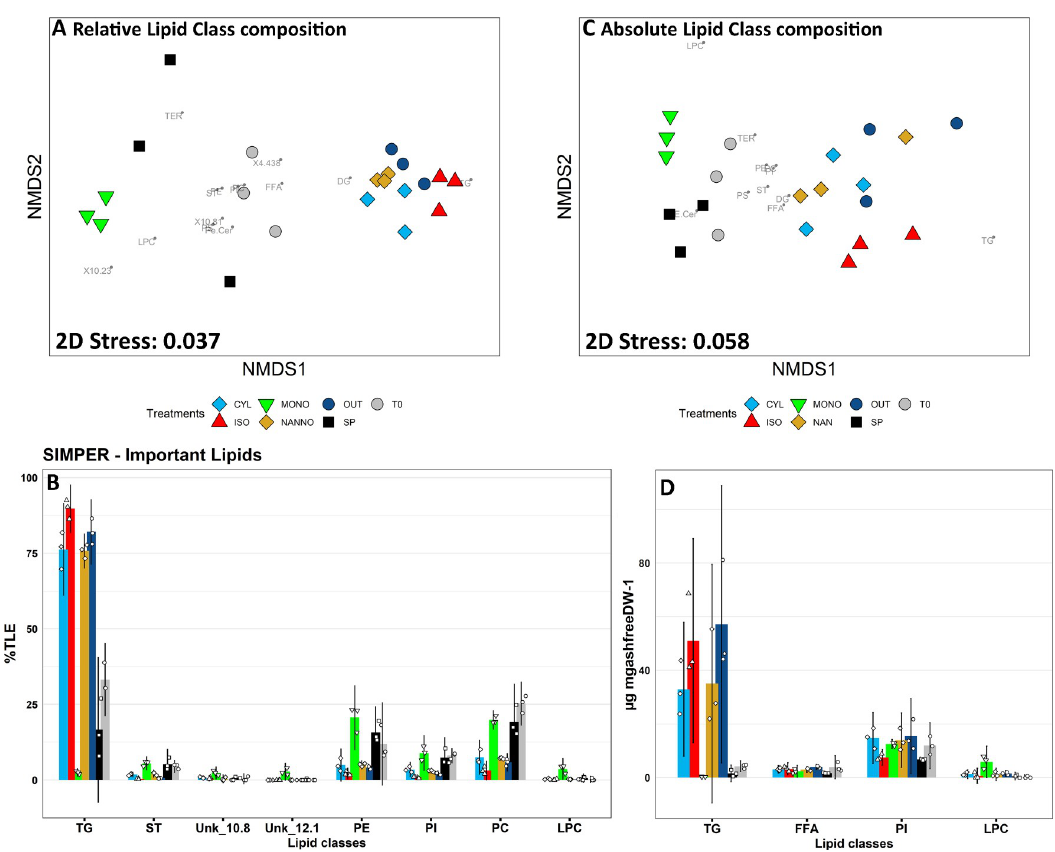
Fig 4. Non metric multidimensional scaling (nMDS) analisis and similarity percentages (SIMPER) analysis for relative (A-B) and absolute (C-D) lipid class composition of spat subjected to the diet treatments. A: nMDS plot for relative lipid class composition of the spat (%TLE) subjected to the feeding trial. Single lipid class loadings are stacked on the plot and reported in grey. B: principal variables explaining for a cumulative 75% of group differences in relative spat lipid class composition data evidenced by SIMPER analysis. C: nMDS plot of the absolute ( μ g mg ashfreeDW-1 ) lipid class composition of the spat. Single lipid class loadings are stacked on the plot and reported in grey. D: principal variables explaining for a cumulative 75% of group differences in absolute spat lipid class composition data evidenced by SIMPER analysis. T0: Spat sampled before the beginning of the trial; SP: spat fed with Shellfish Paste during the 4 weeks trial; CYL: spat fed with C. fusiformis 1017/2 during the 4 weeks diet trial; ISO: spat fed with I. galbana 927/1 during the 4 weeks diet trial; MONO: spat fed with M. subterranean 848/1 during the 4 weeks trial; NAN: spat fed with N. oceanica 849/10 during the 4 weeks trial; OUT: spat deployed outdoor and sampled after 4 weeks. Three replicates (n = 3) for each sample group are here reported. Charts B-D: data are reported as average (histogram) ± 95% confidence interval; individual observations are jittered on the chart (smaller dots).The complete data for lipid class analysis and statistical significance values are found in S3 Table.